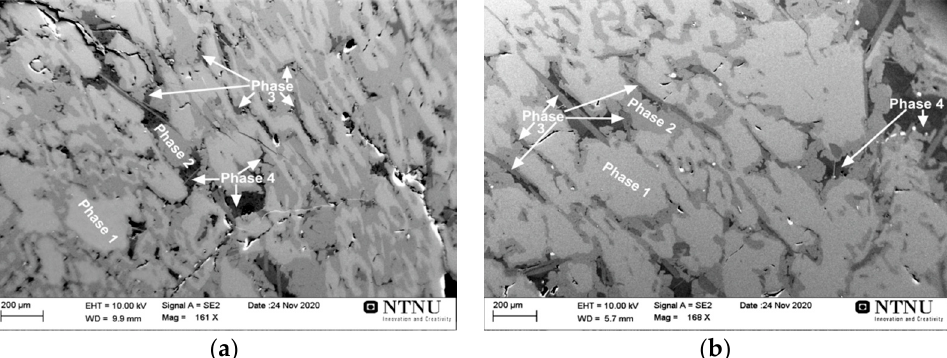
Figure 8. The SEM/EDS microstructural analysis of the cross-section of the metal produced in exp. 3 ( a ) and exp. 4 ( b ).